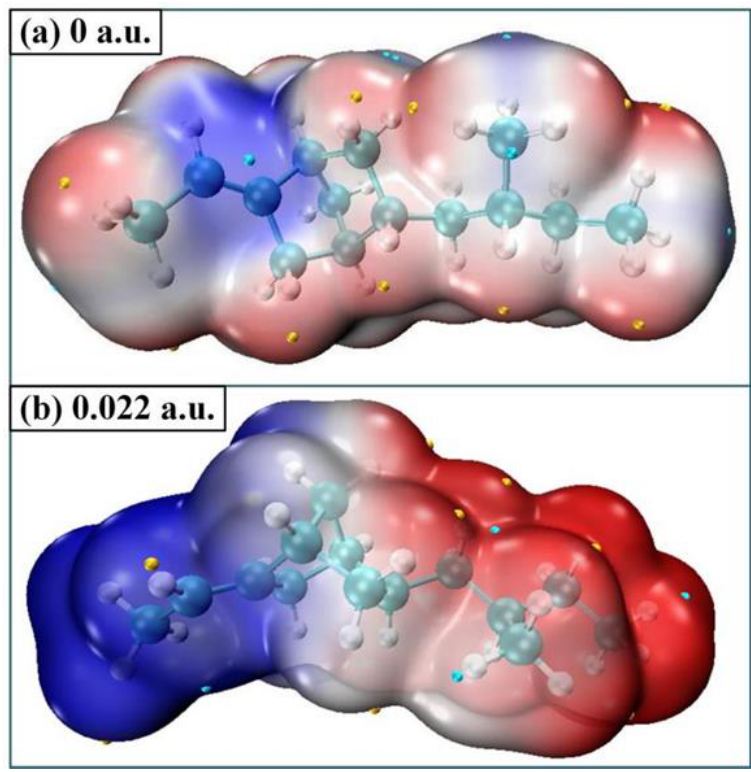
Figure 9. Molecular electrostatic potential surface at 0 a.u. and 0.022 a.u.